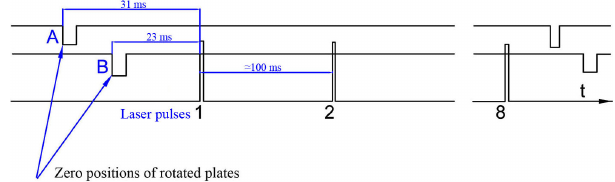
Figure 6. Time positions of the laser pulses relative to the zero po- sitions of the plates. The situation repeats every eight